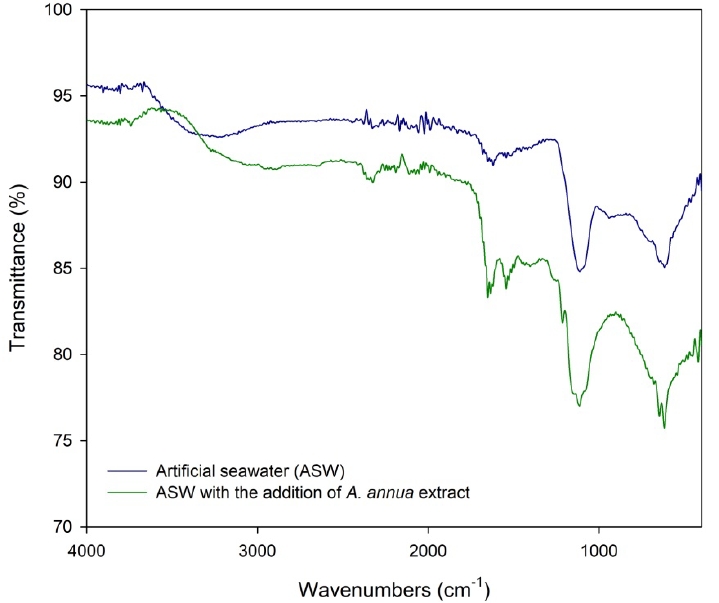
Figure 6 . FTIR spectra of the Al alloy 5083 surface after 24 h immersion in ASW without and with the addition of AAE (1 g L − 1 ).